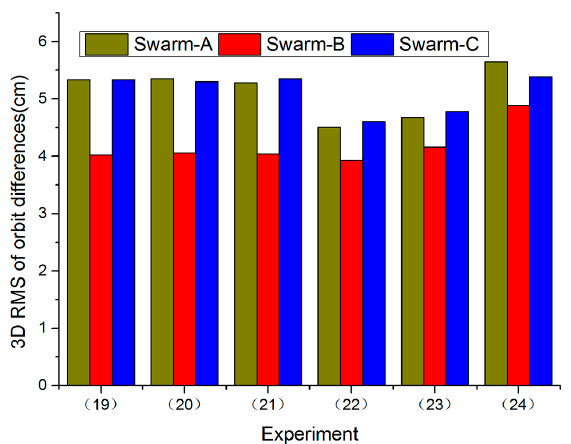
Figure 5. RMS values of orbit differences for all Swarm satellites in 3D direction between Swarm POD and PSOs released by ESA from Experiments (19) to (24), 1 November 2014